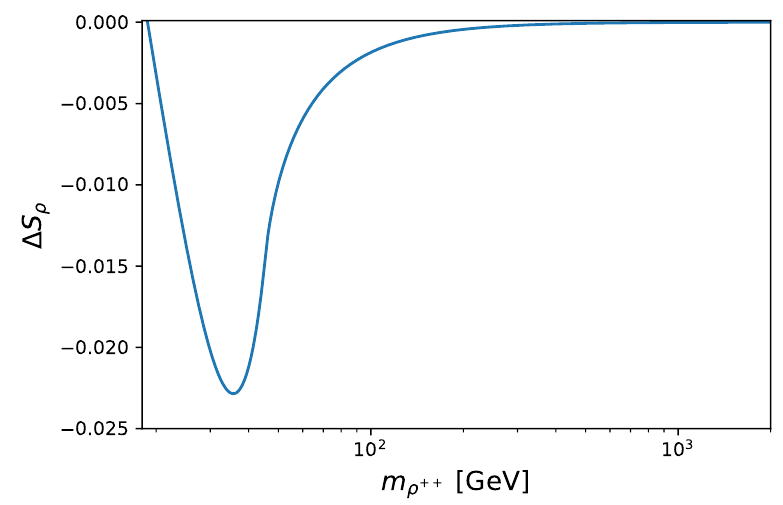
Figure 4 . Contribution to the oblique parameter S from the SU(2) L singlet (cid:26) ++ as a function of its mass m (cid:26) . Current experimental result is S = 0 : 02